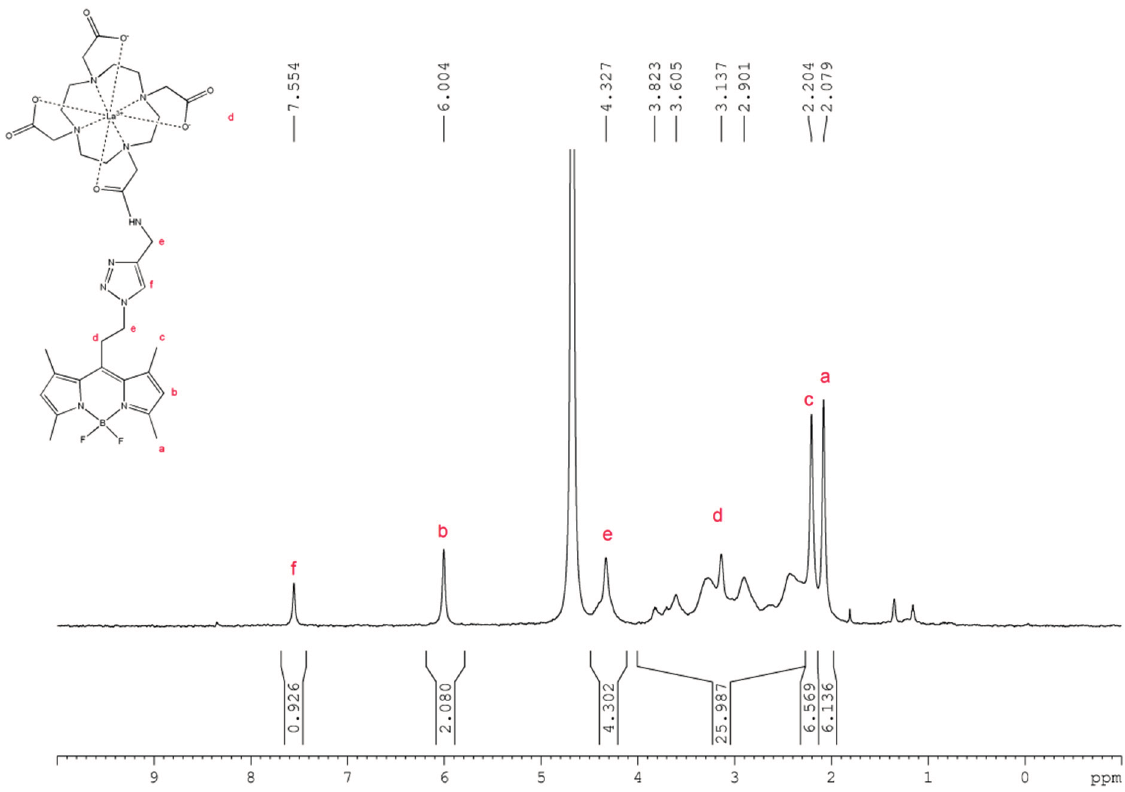
Figure 3. 1 H NMR spectrum of the final clicked La-DOTA-BODIPY derivative measured in deuterated